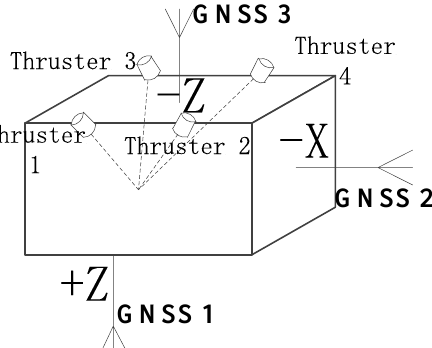
Figure 1. Time-dependent graph of satellite height. Four HET300 Hall electric thrusters are used in the electric propulsion system to realize the orbit control of the satellite. These are installed on the − Z side of the satellite, and the thrust direction of each thruster is through the center of mass of the satellite. The installation layout is shown in Figure 2.